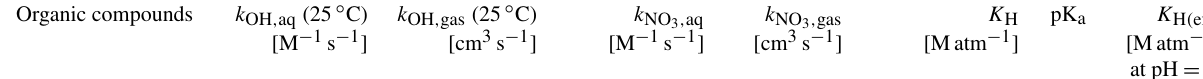
) and gas phases ( k OH , gas ; k NO ) and physical Henry’s 3 , aq 3 , gas